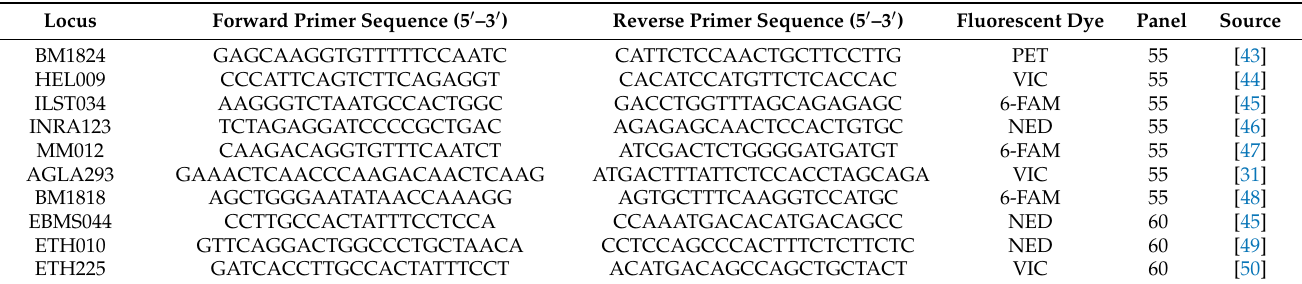
Table 2. Microsatellite markers with information about source